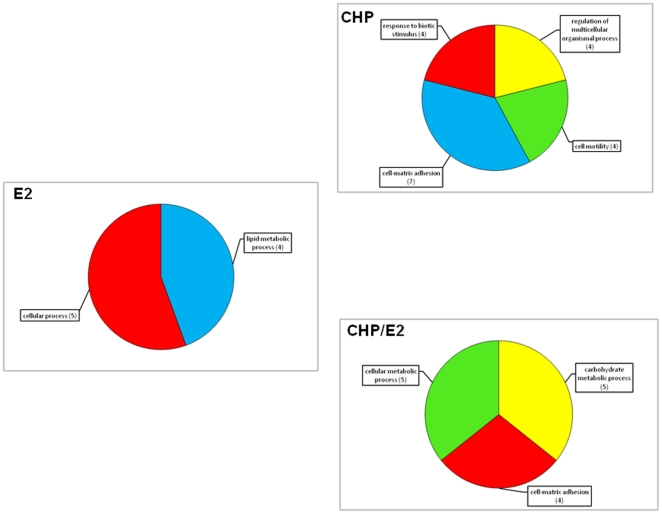
Functional genomics analysis: multi-level GO pie charts.The GO terms (biological processes) associated with the mussel sequences
present in the array that resulted enriched by each treatment are
reported (hypergeometric statistics, p<0.05). Due to
the hierarchical structure of the GO tree, only the lowest nodes with at
least four associated sequences were depicted. Additional information is
given in Table S2.